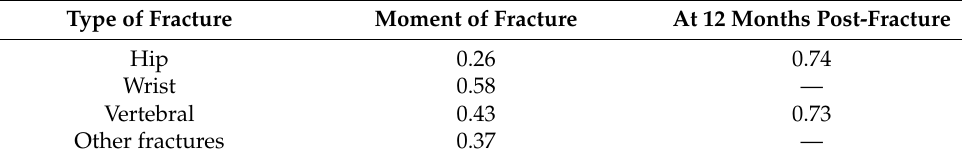
Table 6. Utility at 12 months after each type of fracture. Type of Fracture Moment of Fracture At 12 Months Post-Fracture Hip 0.26 0.74 Wrist 0.58 — Vertebral 0.43 0.73 Other fractures